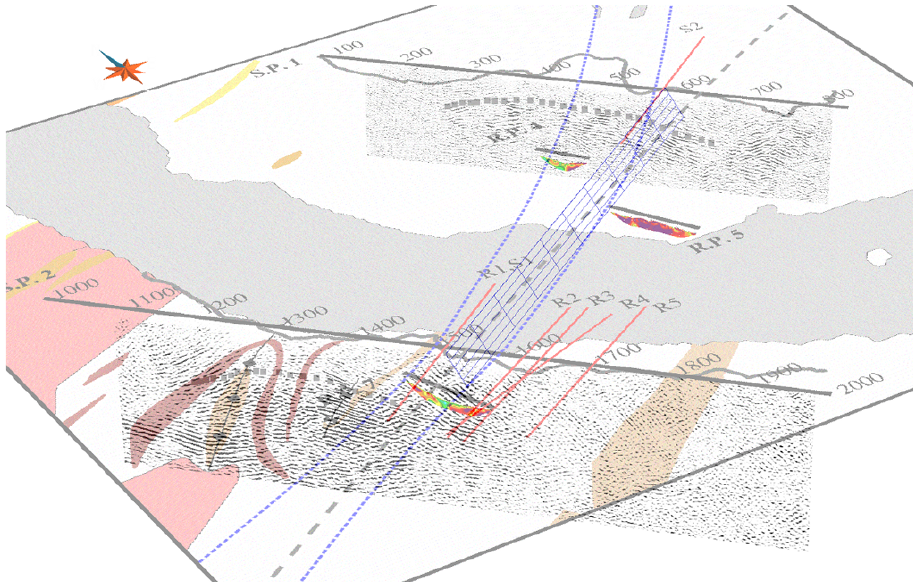
Fig. 14. Seismic profiles 1 and 2 and resistivity profiles 4, 5 and 7 plotted with geology in 3-D perspective view. Blue dashed lines indicates topographic lineament and red solid lines mark reflections S2, S1/R1–R5. See Fig. 2 for locations. The blue plane indicates the modeled fault plane with strike 55 ◦ and dipping 55 ◦ towards south east. The plane extends to 400m depth in this figure. Antiform structures are enhanced with gray squares. The fold hinge line seems to be subparallel to the fault